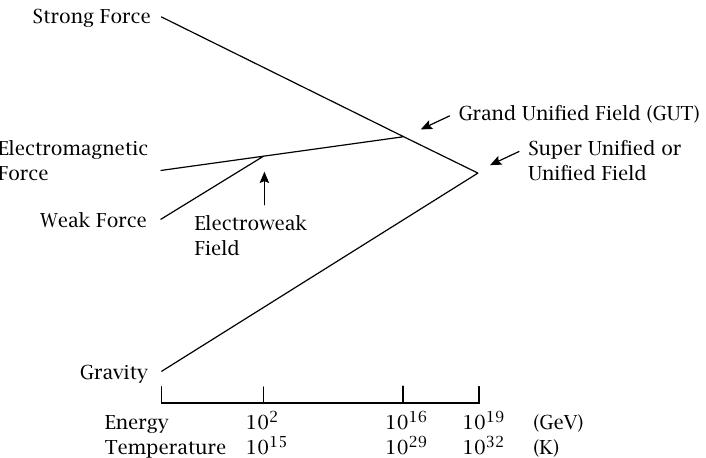
Figure 1 . Schematic representation of the strength of the force fields as a function of energy (per particle) or